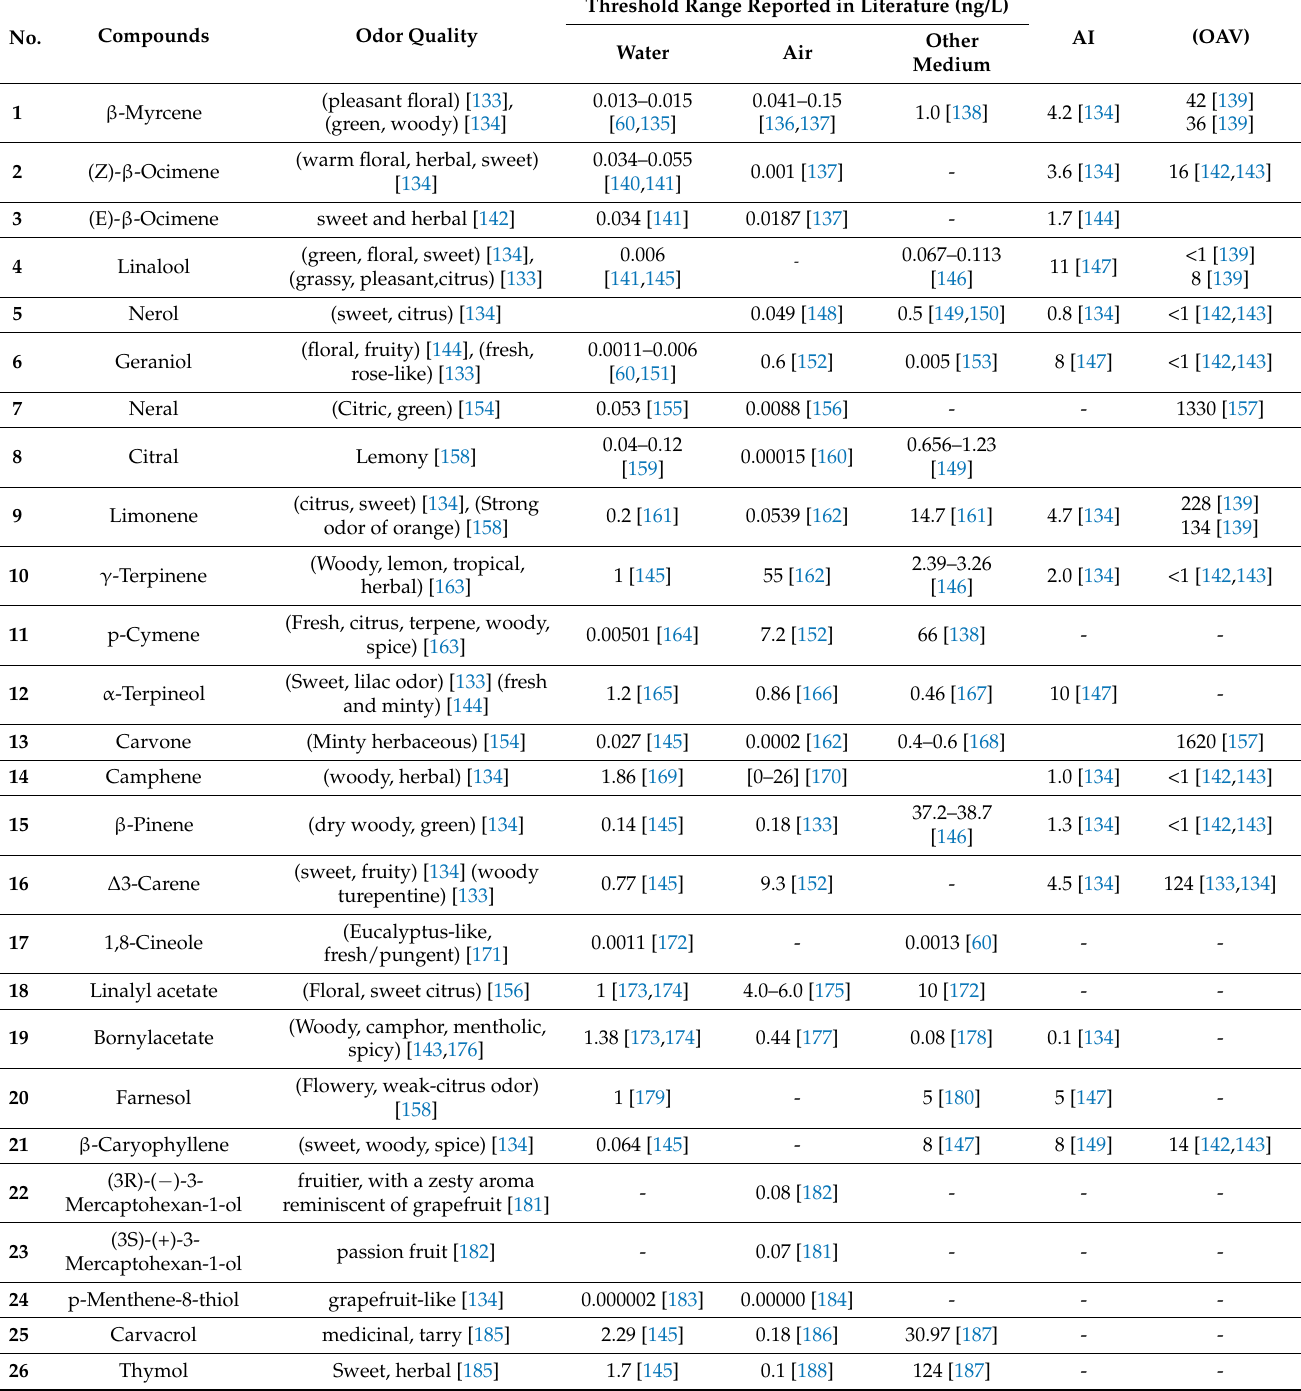
Table 1. Sensory properties of some volatile